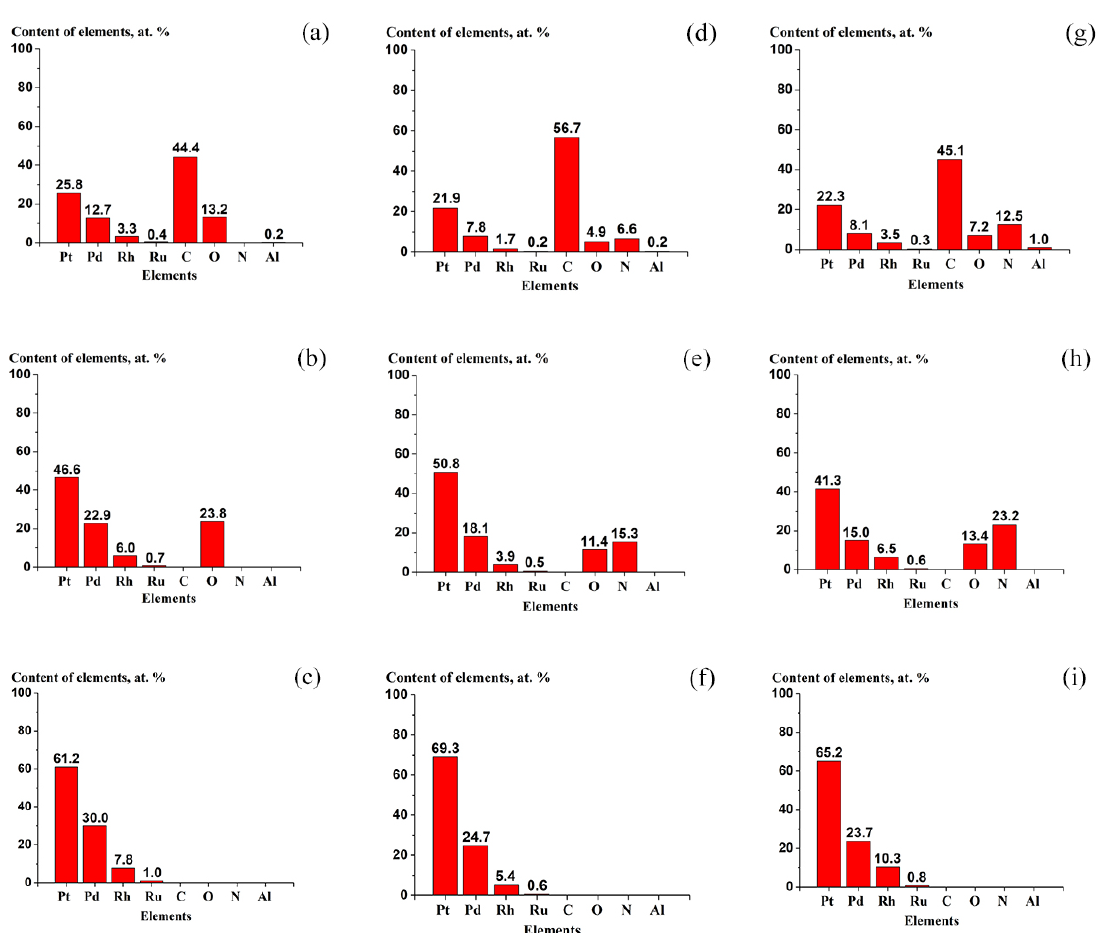
Figure 7. The content of elements measured by EDS for the new Pt–Pd–Rh–Ru gauze ( a – c ) and also for the back ( d – f ) and frontal ( g – i ) sides of the gauze after NH 3 oxidation. ( a , d , g ) Concentrations of all the detected elements in the wire subsurface layer on all the gauzes. ( b , e , h ) Relative concentrations of elements in the subsurface layer calculated from the data of ( a , d , g ) after excluding C and Al from the list of detected elements. ( c , f , i ) Relative concentrations of metals calculated from the data of ( b , e , h ) after excluding O and N from the list of elements.